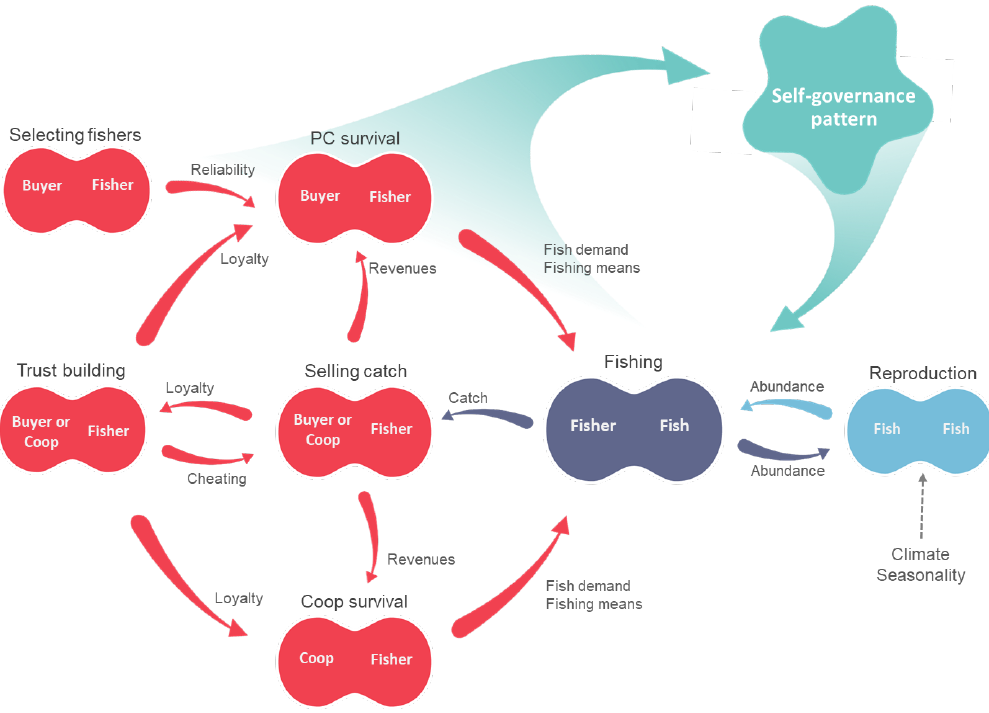
Figure A3: SE-AS representation of the configuration of social- ecological (dark blue) and social action situations (red) hypothesized to explain the dominance of patron-client relationships versus cooperatives in small-scale fisheries in